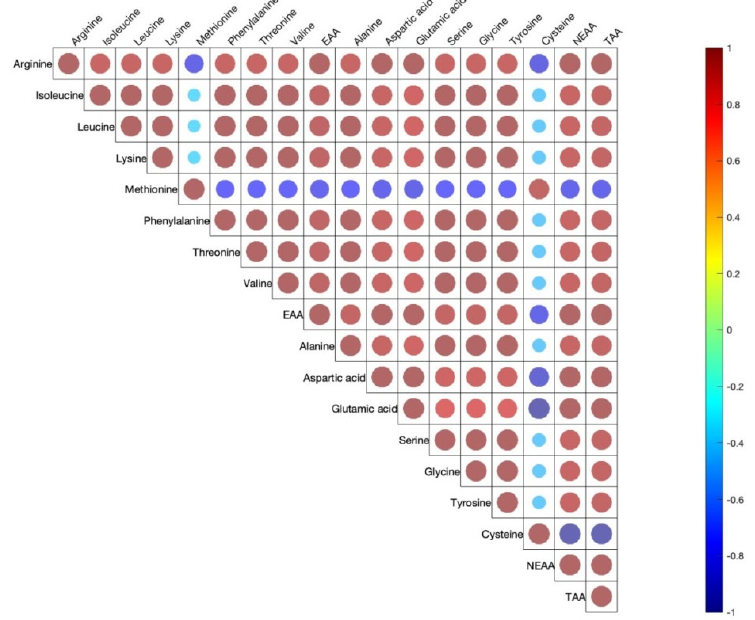
Figure 1. Pearson correlations among egg yolk amino acids. The correlations are expressed by circles. Red and blue circles indicate positive or negative correlations in each pair, respectively ( p < 0.05). Shapes of circles are dependent on weak to strong correlations from big to small circles.